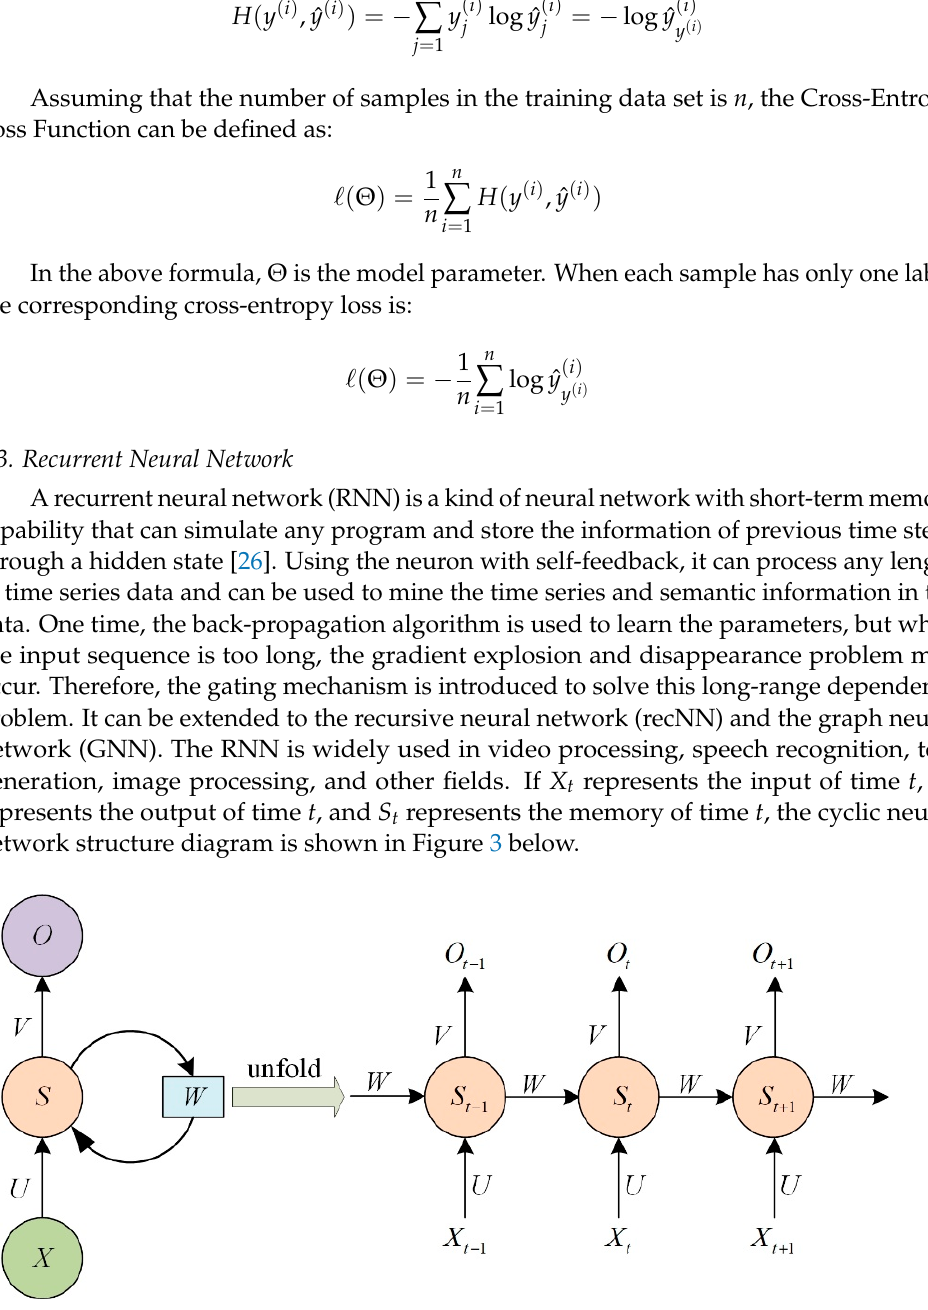
Figure 3. Recurrent neural network structure diagram.